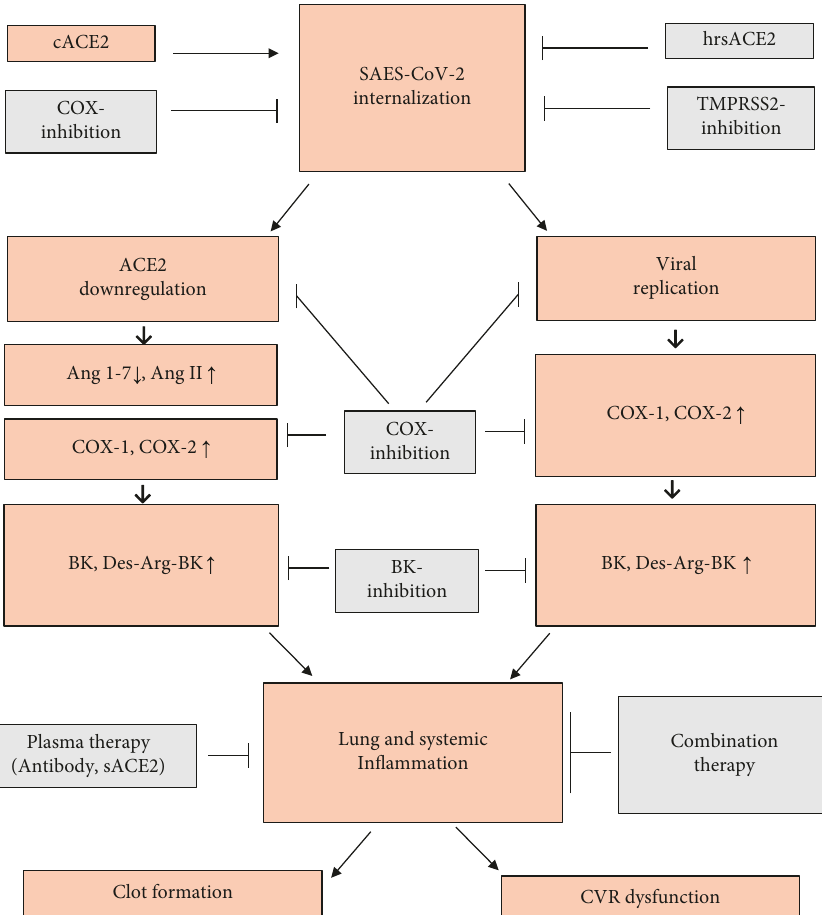
Figure 2: The relationship between sACE2, BK, and COX inhibitor, and plasma therapy in the patients with COVID-19. CVR: